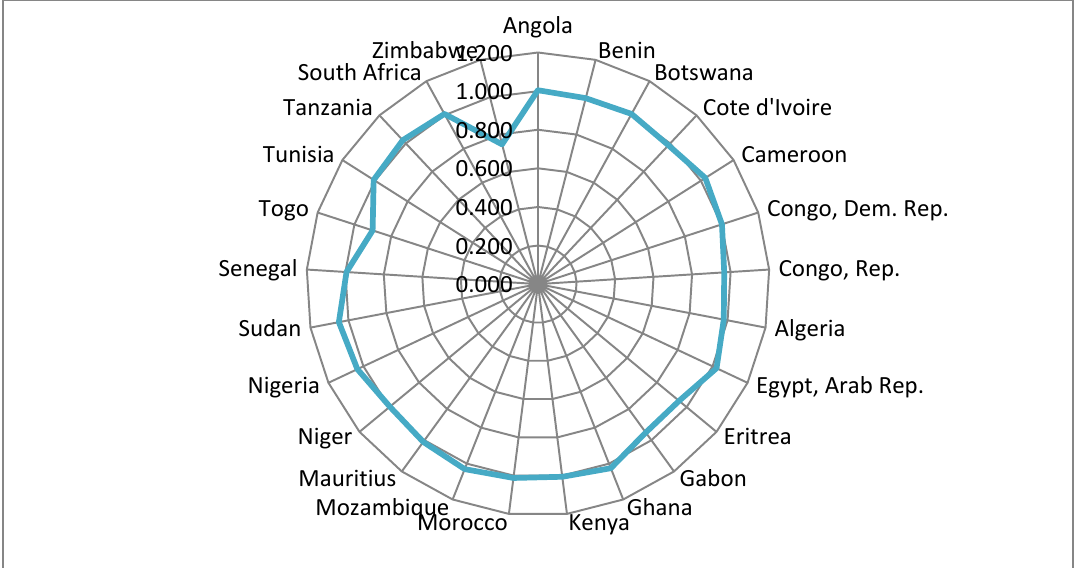
Figure 6. Mean MPI scores without CO 2 emissions for the 25 sample countries in 2006–2014.